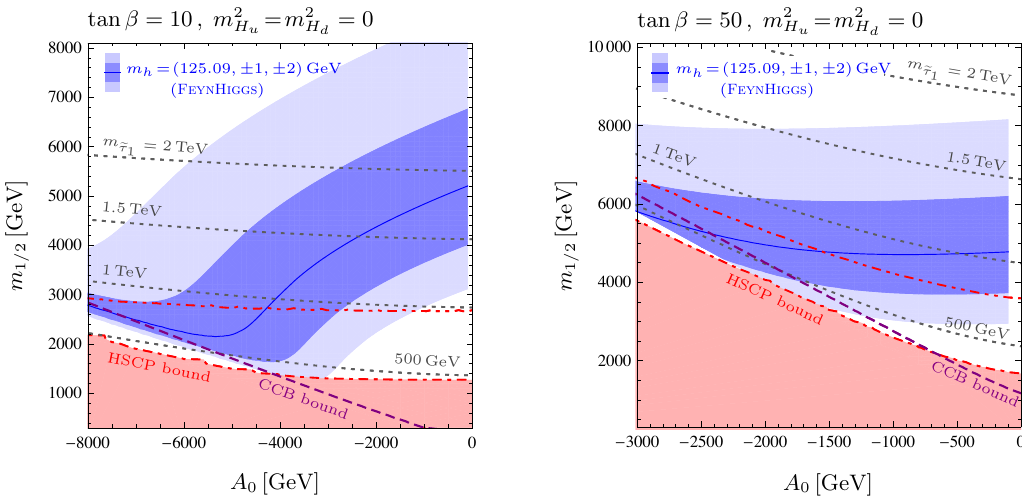
Figure 4 . Contours of m h = 125 : 09 GeV computed by FeynHiggs (blue solid curve) in the A 0 - m plane, as well as constraints from searches for heavy stable charged particles (HSCP) at the 1 = 2 8 TeV LHC (red shaded region below the red dot-dashed curve). Projections for the 13 TeV LHC at 300 fb (cid:0) 1 are indicated by the red dot-dot-dashed curve. The purple dashed line represents the strongest of the CCB constraints from equations (3.9){(3.10). The grey dotted curves show the contours of the lighter stau mass m . For tan (cid:12) = 50 and (cid:0) A 0 & 2 : 3 TeV the HSCP limit (dot- e (cid:28) 1 dashed curve) extents into the region of a tachyonic spectrum, in this region this limit is only an